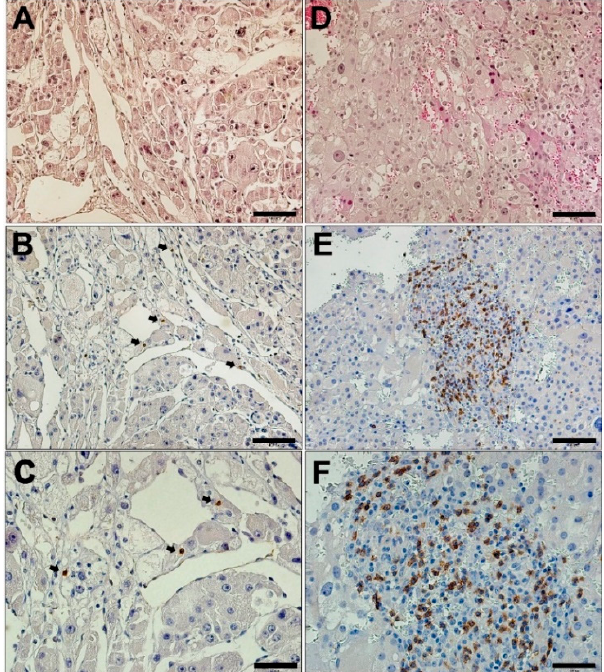
Figure 3. Immunohistochemistry of CD8 in adrenocortical carcinoma (ACC). ( A and D ) Low magnification (20 × ) images of hematoxylin and eosin stain (HE) of ACC. Diffuse, low CD8 immunostaining ( B , 20 × ; C , 40 × ). Nodular CD8 immunostaining ( E , 20 × ; F , 40 × ). Scale bar: A, D, B, and E = 100 µm; C and F = 50 µm.